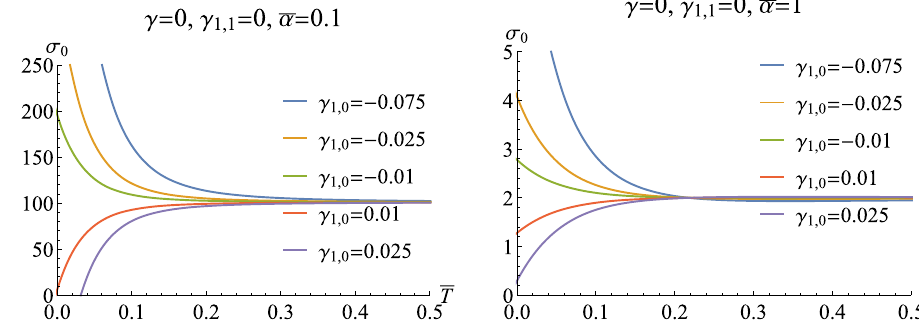
Fig. 1 DC conductivity σ 0 as a function of the temperature ¯ T with different γ 1 , 0 and ¯ α